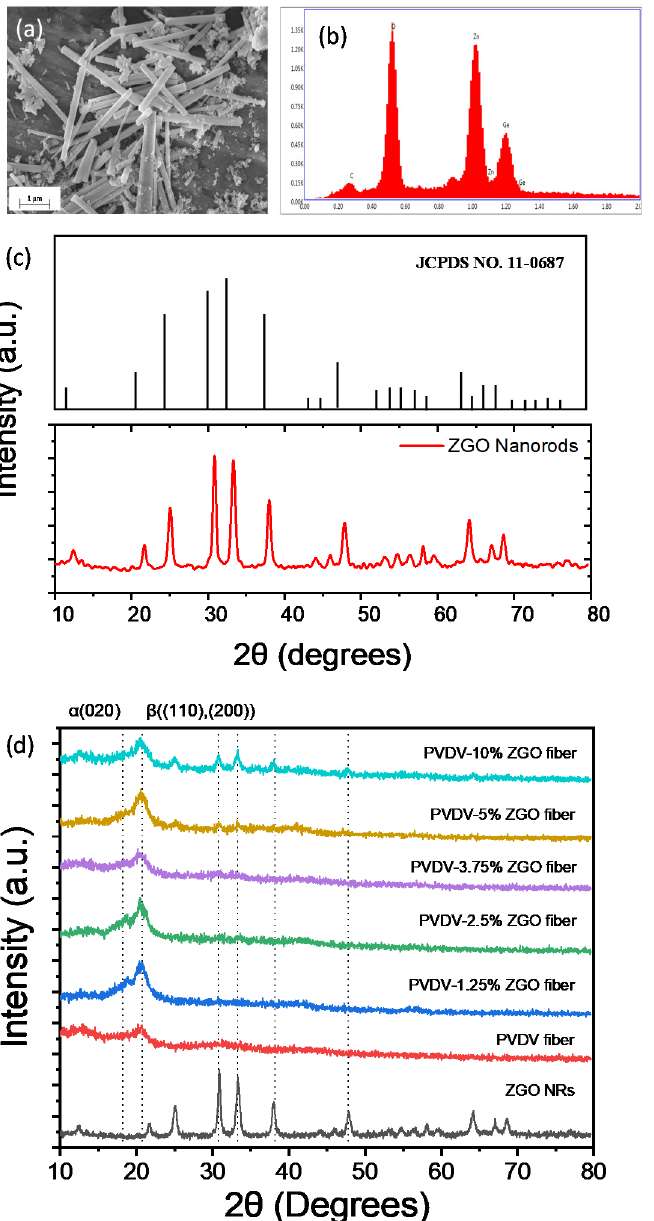
Figure 2. ( a ) SEM micrograph of developed ZGO nanorods, ( b ) EDAX spectra of ZGO nanorods, ( c ) XRD pattern of ZGO nanorods, and ( d ) XRD of pure ZGO nanorods, pure PVDF fibers, and PVDF-ZGO fiber composites (1.25–10 wt % of nanorods).